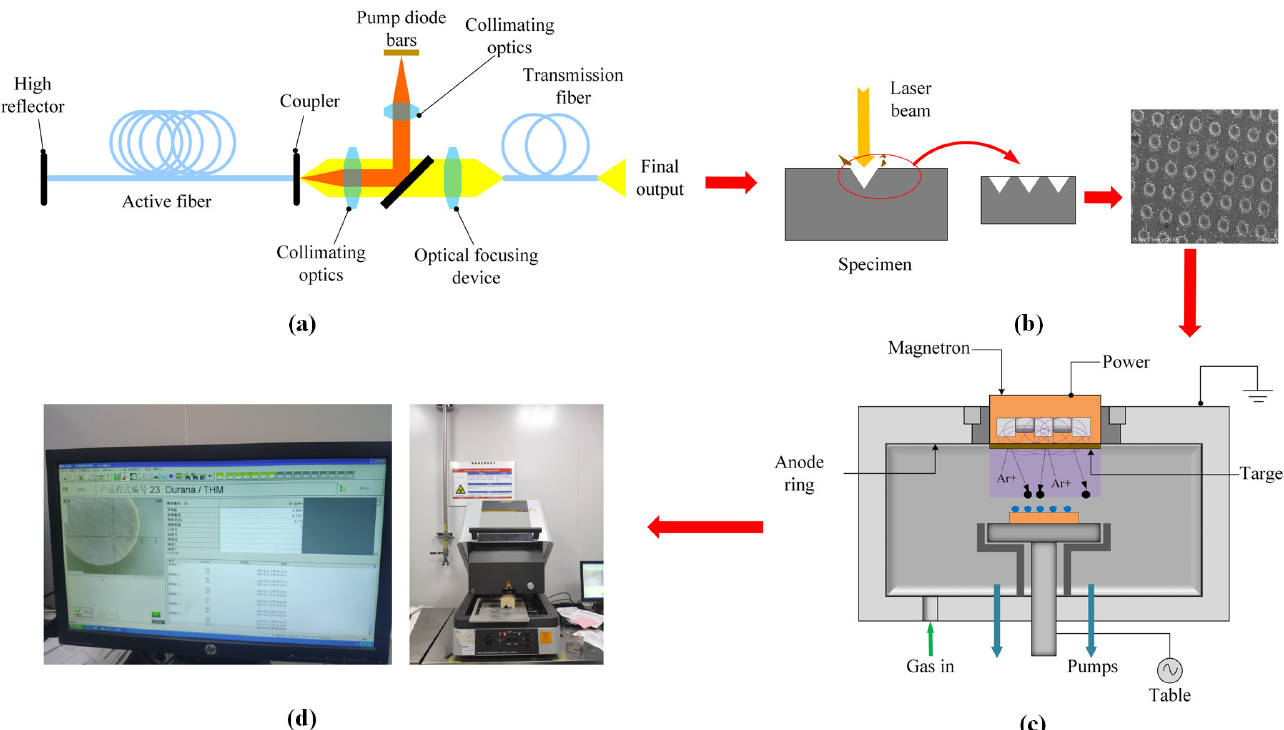
Figure 1. Process flow. ( a ) Principle of Fiber Laser, ( b ) Microtexture preparation, ( c ) Coating Thickness Measuring Instrument, ( d ) Principle of Vapor Deposition.